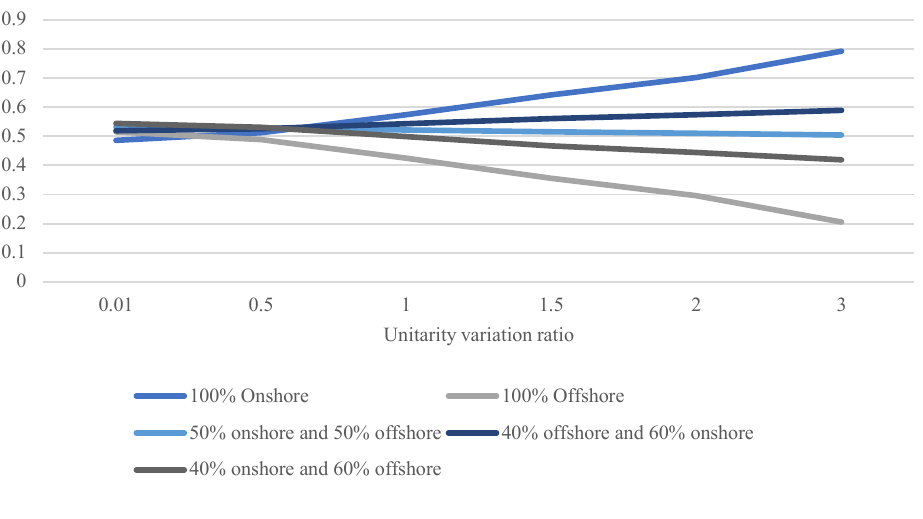
Fig. 5(g). Sensitivity analysis of Community investment